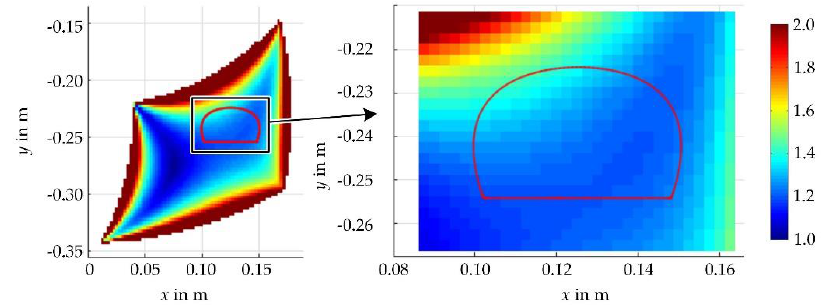
λ / λ 2 1 in the workspace of the manipulator.